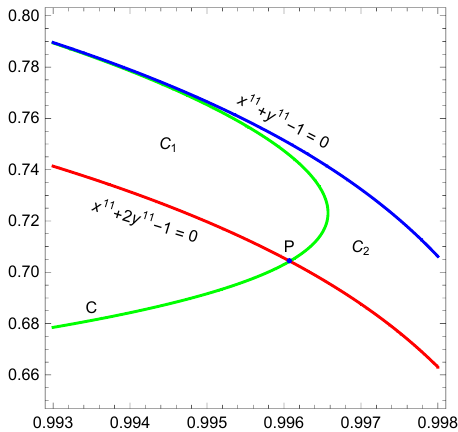
Figure 7. The regions C 1 , C 2 and the curve C in 11-dimensional